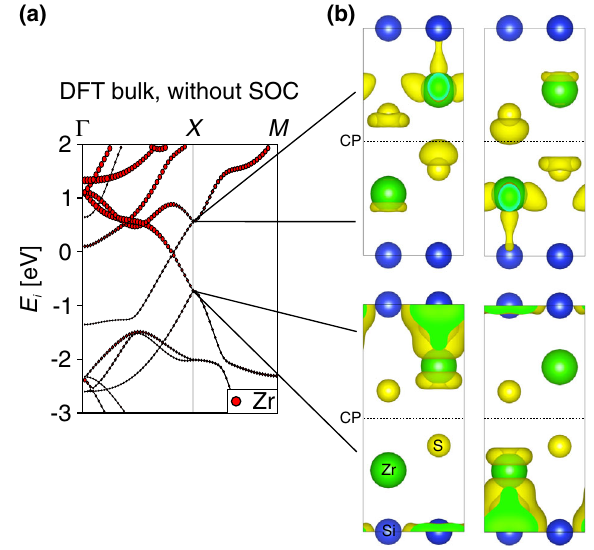
FIG. 5. (a) DFT bulk calculation of ZrSiS. The size of the red colored circles here stands for the overall Zr character in the unit cell, not just of the topmost one, as shown when considering the surface in Figs. 2(b) and 2(f). (b) Orbital character of the bulk bands at the X point shown through the isosurfaces of the charge density. The cleavage plane ( CP ) is shown as a dashed line in the unit cells. The color scale indicates the affiliation to the atoms (green, Zr; blue, Si; yellow, S). For the ZrSiS bulk material, the conduction band minimum at X shows a considerable DOS in the gap between the sulfur atoms, while the valence band maximum is much less affected by the introduction of a